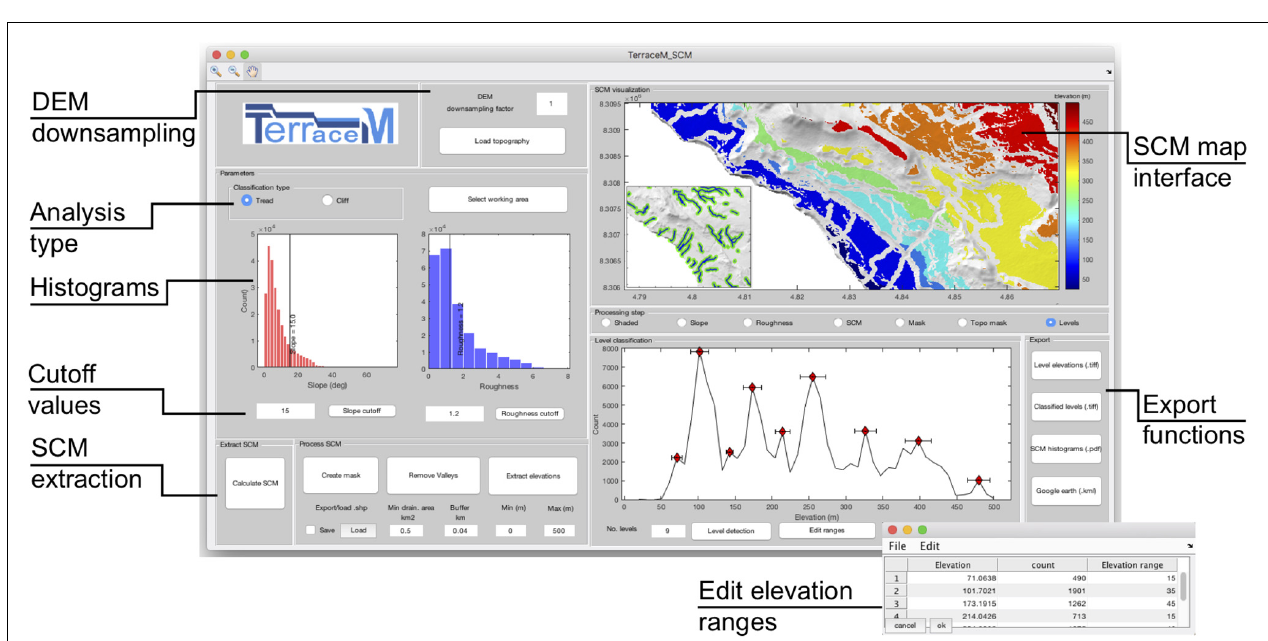
FIGURE 4 | Surface Classification Module (SCM) mapping GUI. Blue and red histograms show distributions of slope and roughness, respectively; vertical black lines are the cut-off values. The upper right plots display the classified terrace levels and the drainage network used to remove false positive classifications.